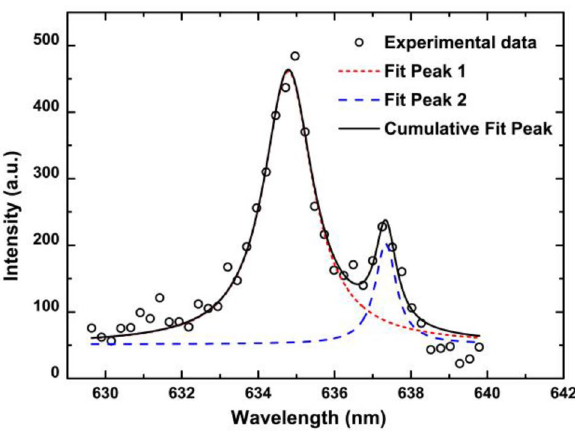
Figure 3. Fittings of two peaks for the Si II lines at approximately 635 nm with the Voigt function.